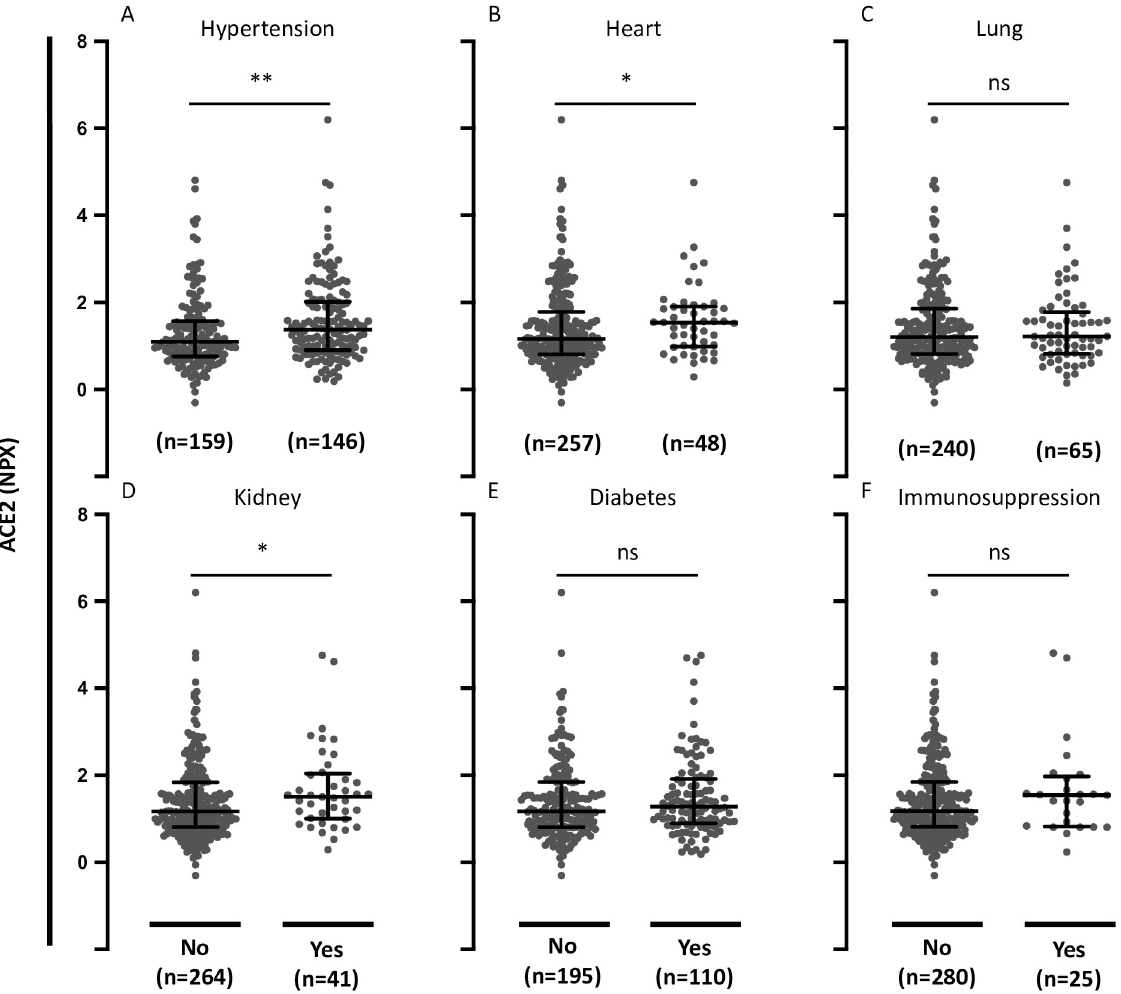
Fig 4. Plasma ACE2 in COVID-19-positive patients with comorbidities. A. Plasma ACE2 in COVID-19-positive patients with or without pre-existing hypertension. B. Plasma ACE2 in COVID-19-positive patients with or without pre-existing heart disease (coronary artery disease, congestive heart failure, valvular disease). C. Plasma ACE2 in COVID-19-positive patients with or without pre-existing lung disease (asthma, COPD, requiring home O 2 , any chronic lung condition). D. Plasma ACE2 in COVID-19-positive patients with or without pre- existing kidney disease (chronic kidney disease, baseline creatinine > 1.5, ESRD). E. Plasma ACE2 in COVID-19-positive patients with or without pre-existing diabetes (pre-diabetes, insulin and non-insulin dependent diabetes). F. Plasma ACE2 in COVID-19-positive patients with or without pre-existing immunocompromised condition (active cancer, chemotherapy, transplant, immunosuppressant agents, asplenic). Data were analyzed using the Mann Whitney test. Bars indicate median and interquartile range. � P < 0.05. �� P < 0.01. ns = not